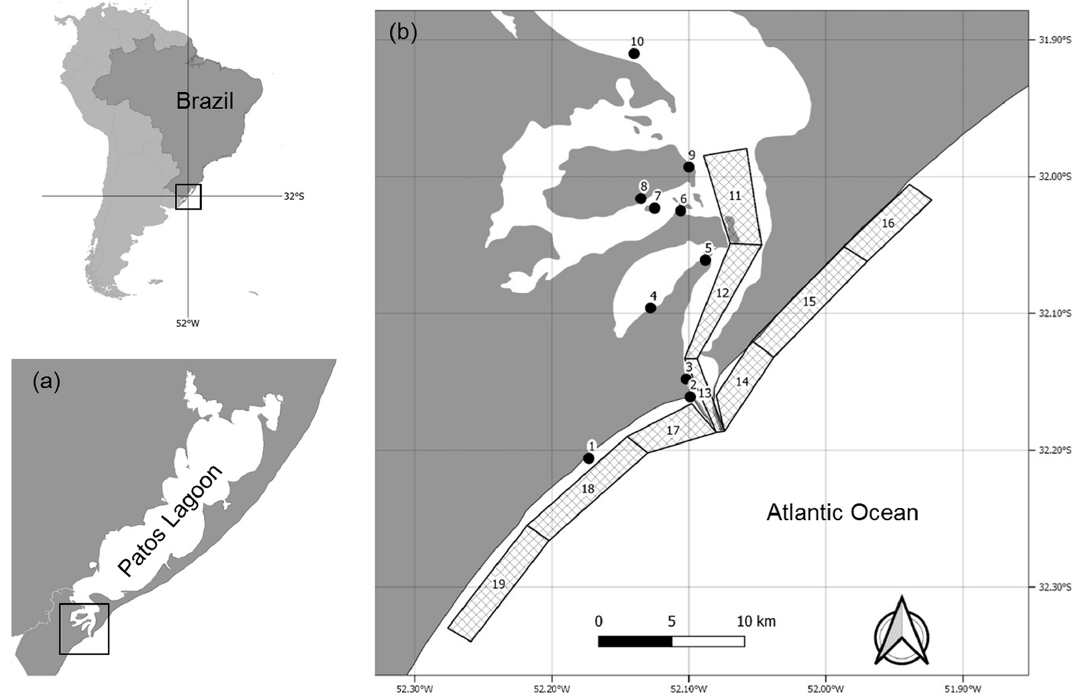
Figure 1. Study area. (a) Patos Lagoon, southern Brazil. (b) Map of the sampling points in the Patos Lagoon estuary and adjacent marine coast (PLEA) for the LTER-PLEA’s dataset samplings. The sampling points are described in Table